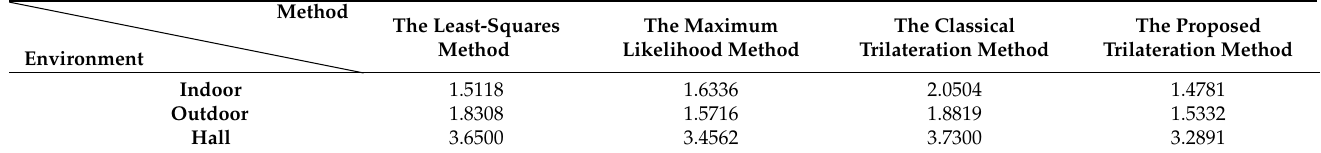
Table 5. The positioning error of the four methods in different environments.